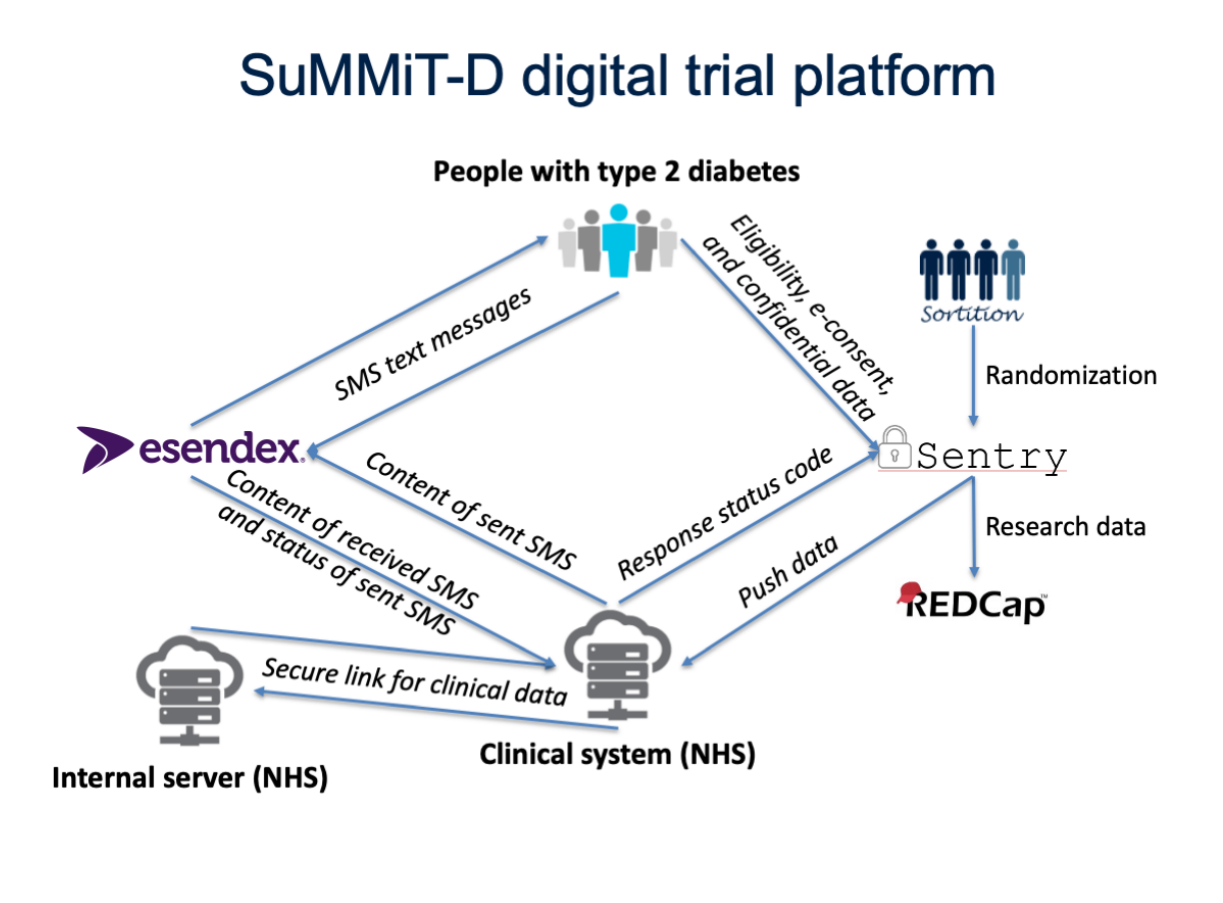
Figure 1. Overview of systems developed for the Support through Mobile Messaging and Digital Health Technology for Diabetes study. Sentry: Secure entry; SuMMiT-D: Support Through Mobile Messaging and Digital Health Technology for